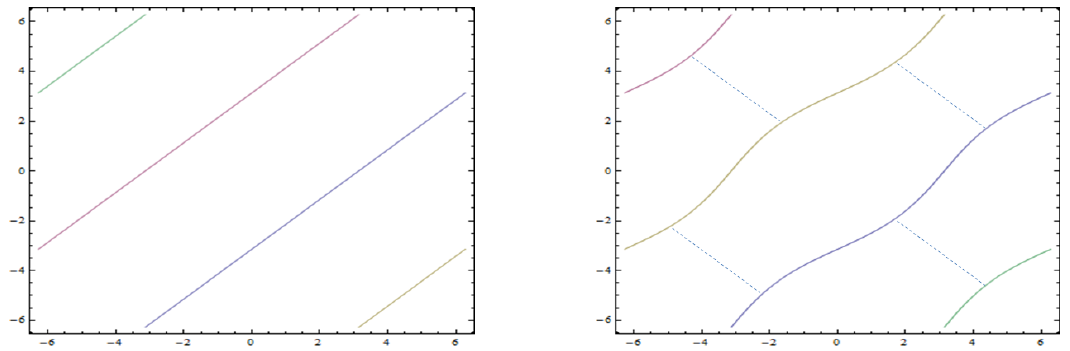
Figure 6 . The left (cid:12)gure represents the phase diagram in the M = 0 case. Nothing depends on (cid:18) + since it is not a parameter in the massless theory. The right (cid:12)gure represents the phase diagram for some small (cid:12)nite mass. At M = 0, the discrete chiral symmetry leads to an N -fold degeneracy in each region away from the transitions (at which there are 2 N vacua), while at M > 0, the vacuum is unique away from the transition lines. The dashed lines disappear as we take M =